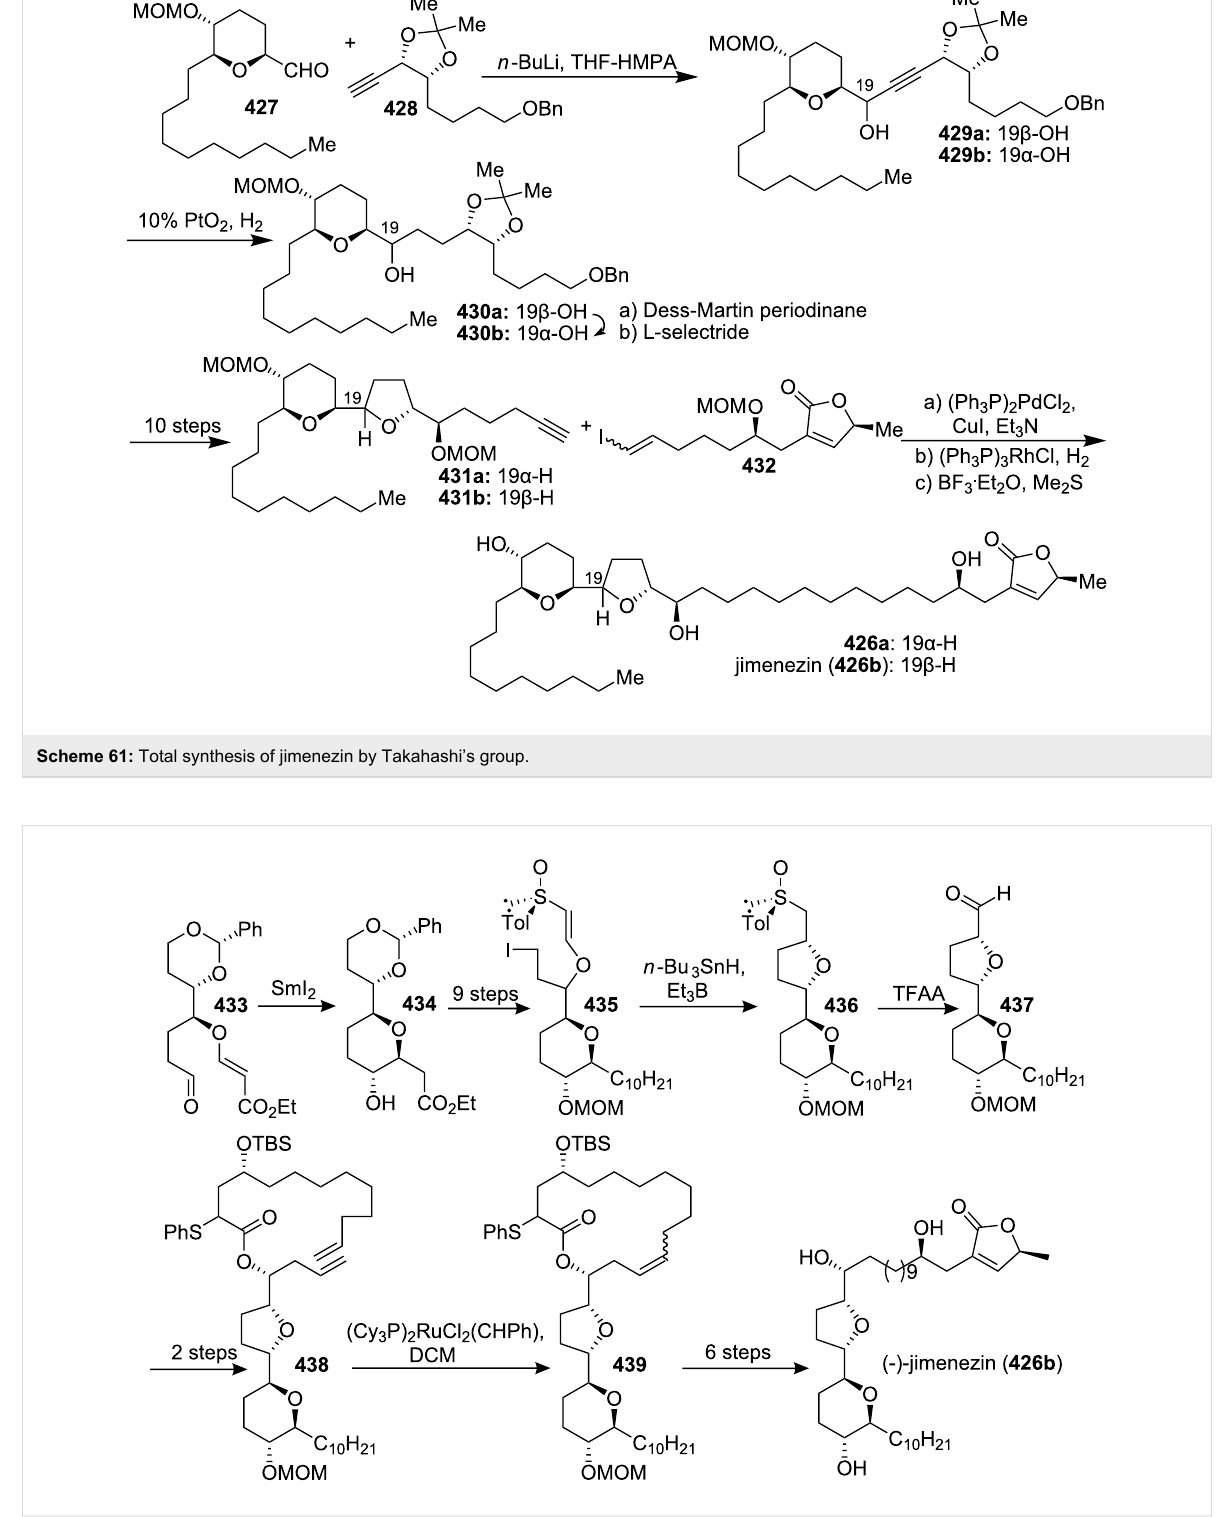
Scheme 62: Total synthesis of jimenezin by Lee’s